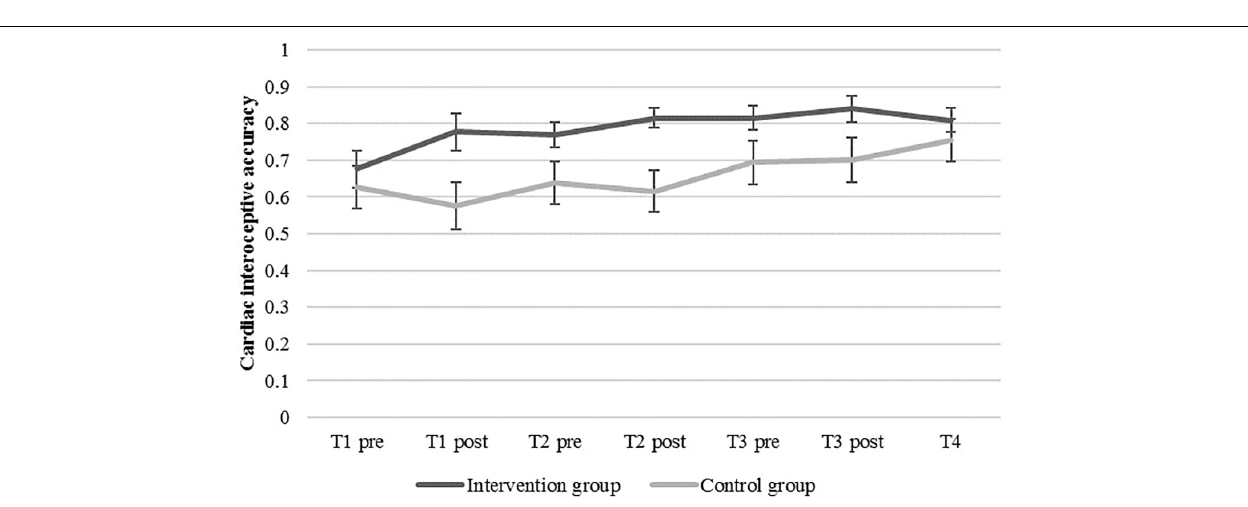
FIGURE 2 | Mean cardiac interoceptive accuracy and standard errors in the intervention and the control group before (T1 pre ) and after (T1 post ) the first heartbeat perception training session ( ∗∗∗ p < 0.001).